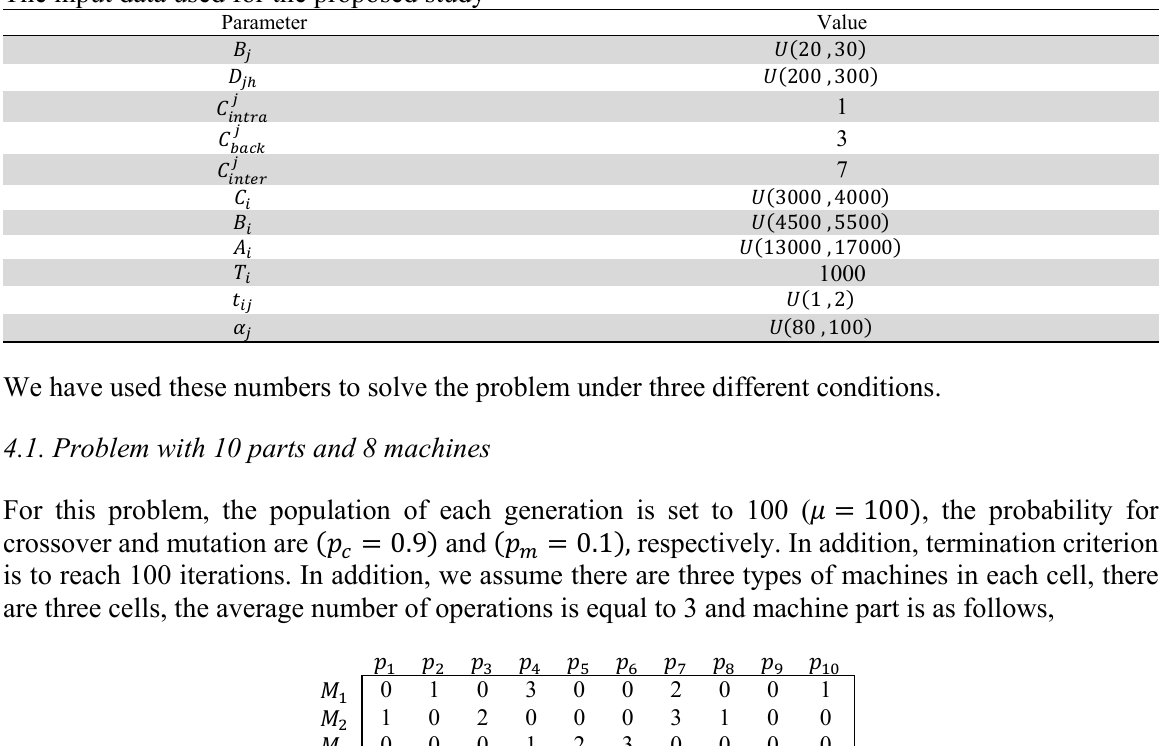
The results of comparison of GA versus optimal solution using Lingo software